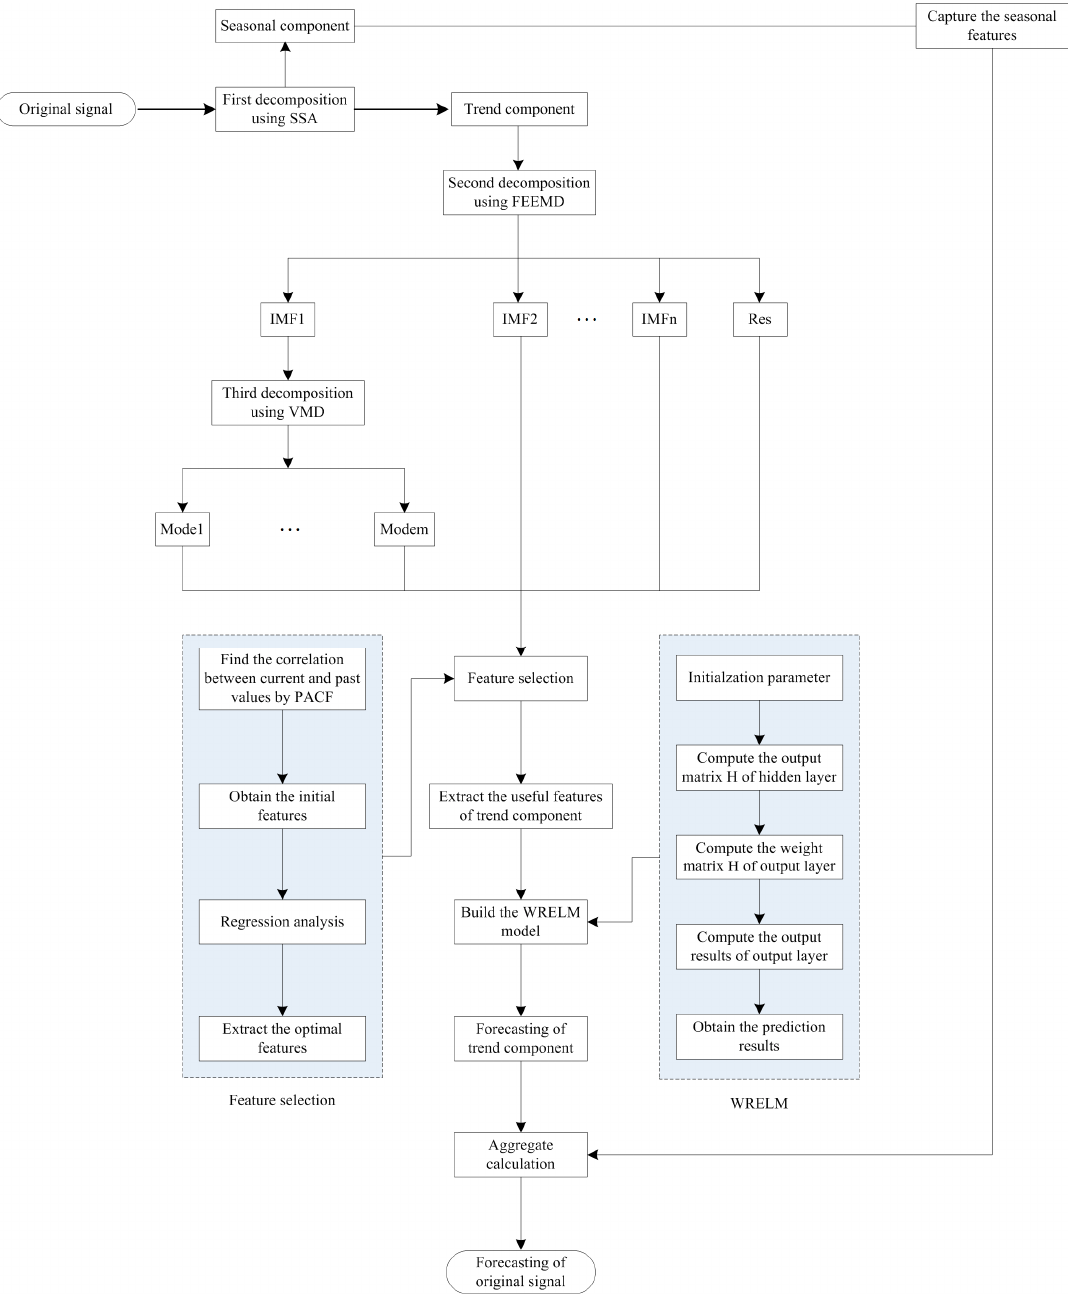
Figure 2. The framework of the proposed approach.